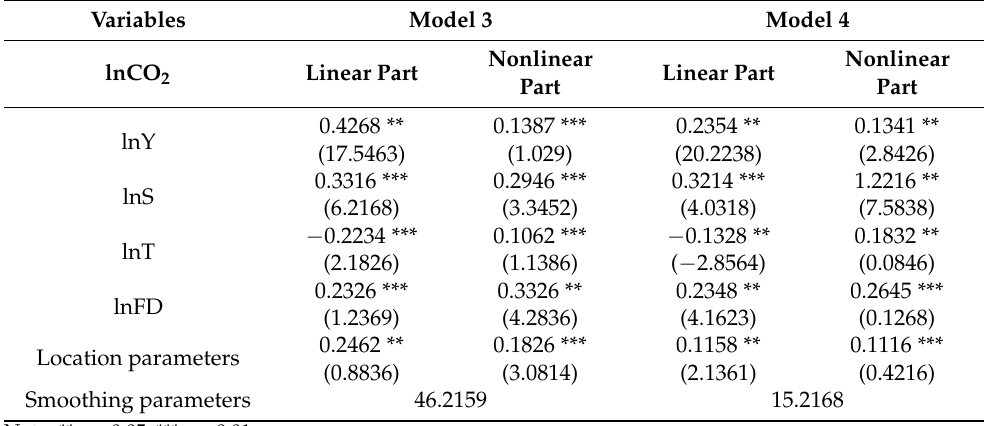
Table 10. Estimated